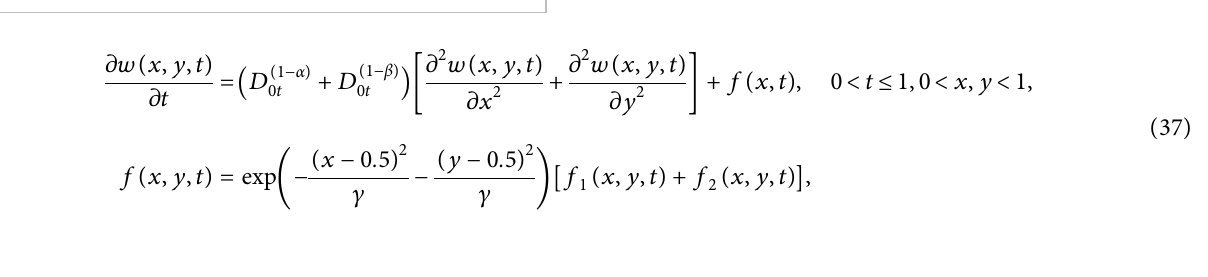
Table 3, for various nodal points N and stencils points n � 11 , 15 and with various values of α and β , the L error norm ∞ is well matched with L error norm. The condition number is 2